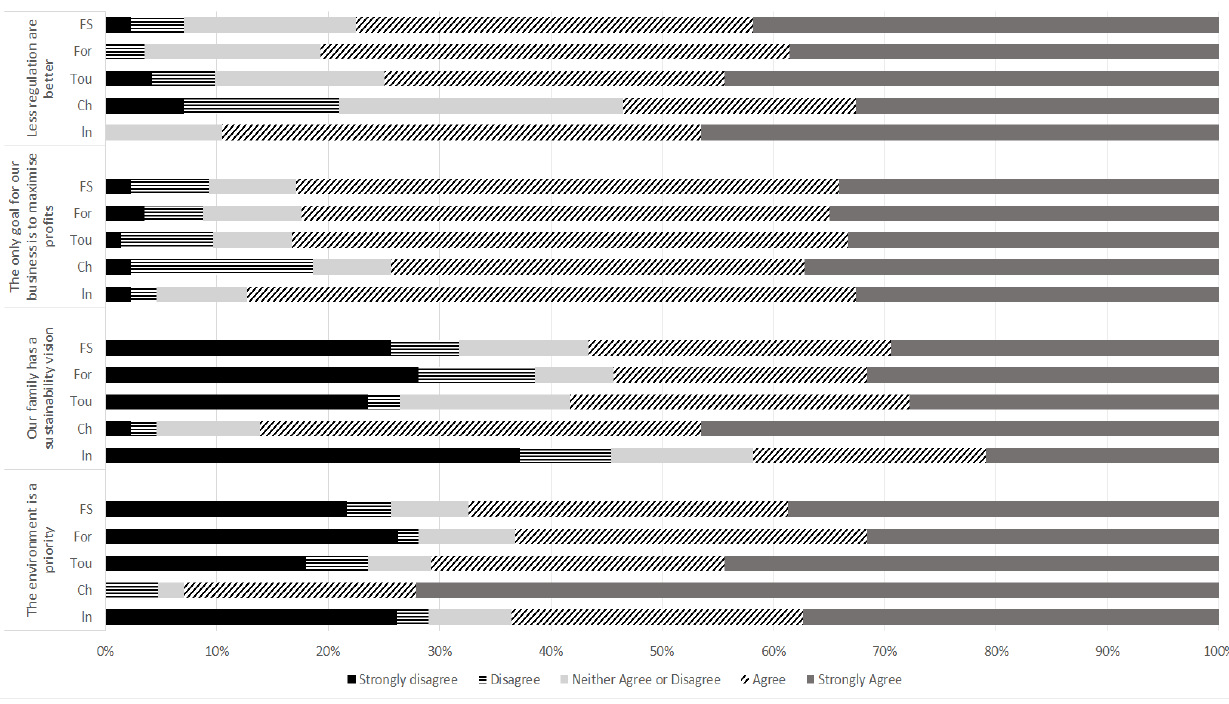
Figure 2. Responses to sustainability statements. Note: FS means full sample ( n = 243); For = forestry ( n = 125); Tou = tourism ( n = 118); Ch = Chile ( n = 117) and In = India ( n = 126).